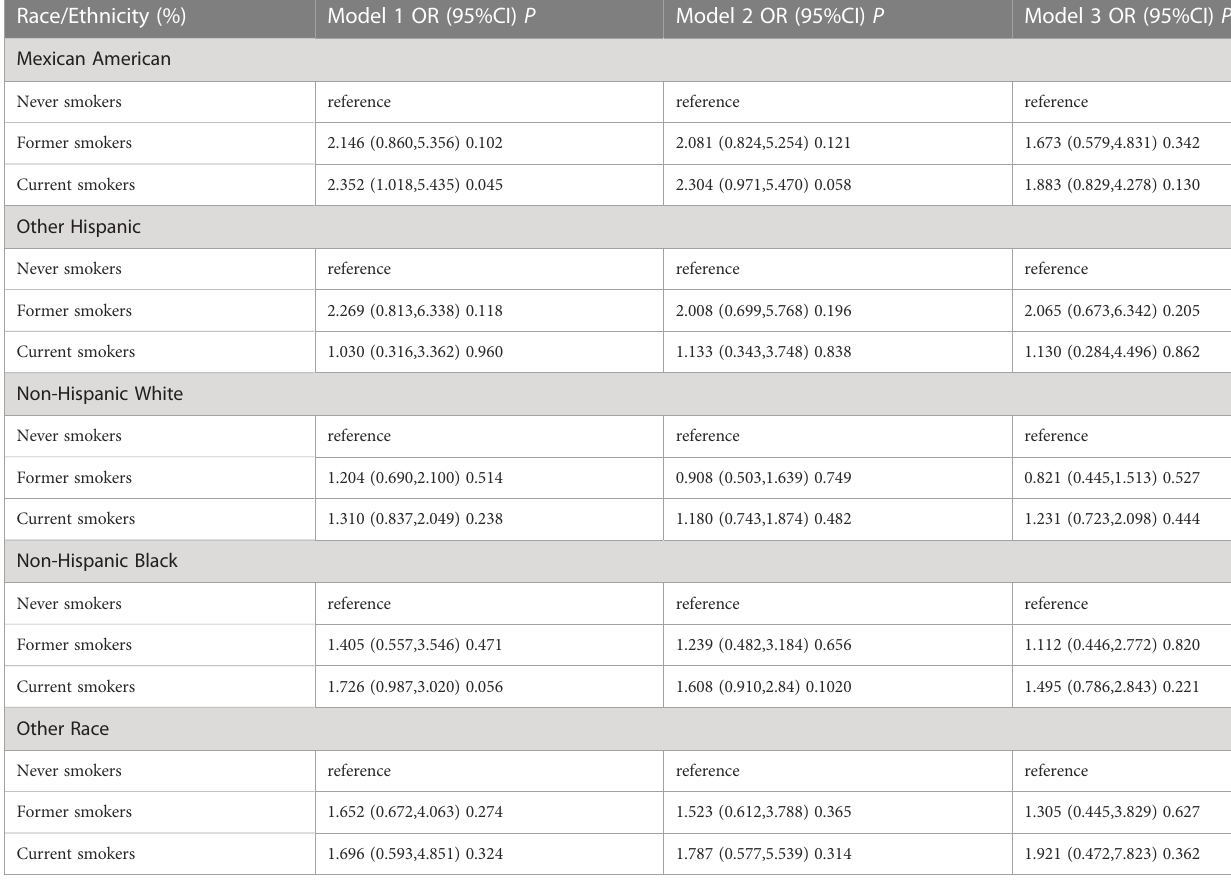
TABLE 3 Association between smoking status and infertility strati fi ed by